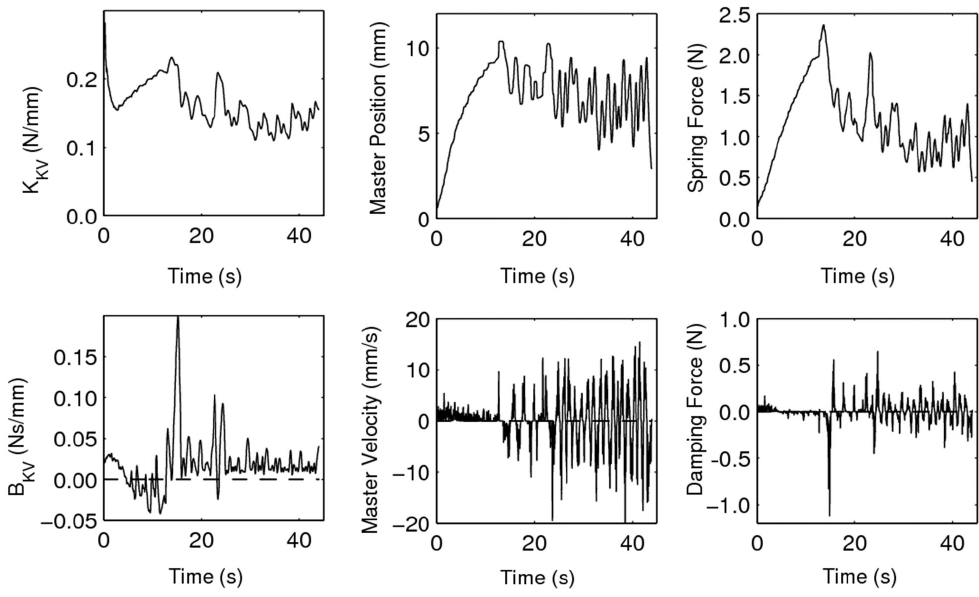
Figure 12. Individual spring and damping force components of the Kelvin–Voigt environment model. The RMSE and mean prediction error for each of the three trials is presented in Table 5.